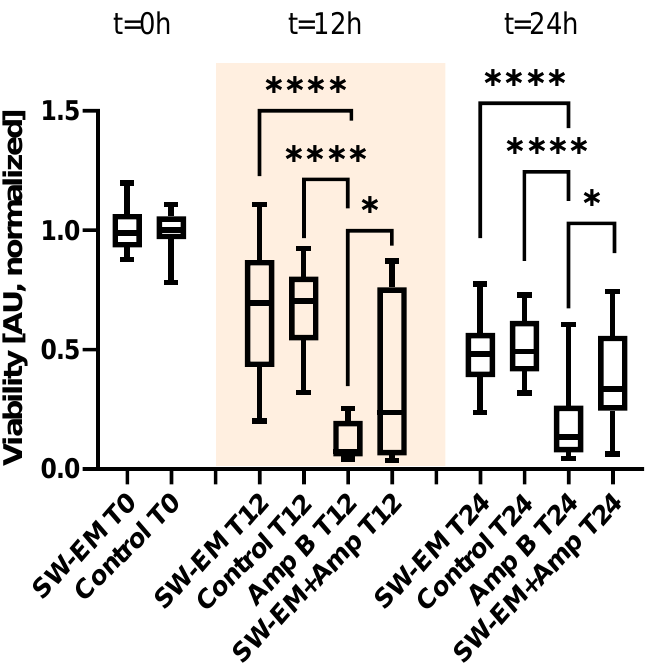
Figure 5. Effects of Amp B on cell viability with or without electromagnetic shockwave (SW-EM) treatment on R. oryzae biofilms grown on a fibrin matrix. The figure shows normalized XTT absorption for healthy and Amp-B-treated biofilms at timepoints T0 h, T12 h, and T24 h. There is a marked increased viability for the shockwave-treated biofilm over the Amp B only group after both 12 h (AU 0.07 → 0.24) and 24 h (AU 0.13 → 0.34). (* p > 0.05, **** p > 0.0001).